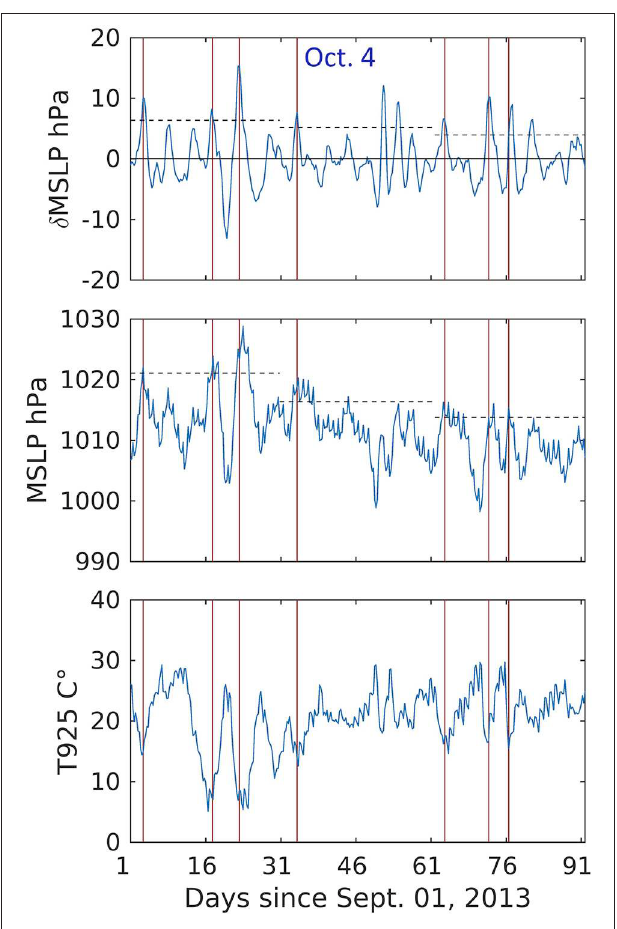
FIGURE 2 | Time series of (top) 24-h Sea Level Pressure tendencies ( δ MSLP ), (middle) averaged Sea Level Pressure ( MSLP ) and (bottom) 925-hPa air temperature averaged in the area between 55.5 ◦ - 60 ◦ W and 22.50 ◦ -27.00 ◦ S coordinates, starting from the beginning of Sept. until the end of Nov. 2013. The vertical lines mark CAI events detected during this period. The horizontal dashed lines show the monthly 10th percentile of δ MSLP and MSLP in the top and middle panels, respectively.